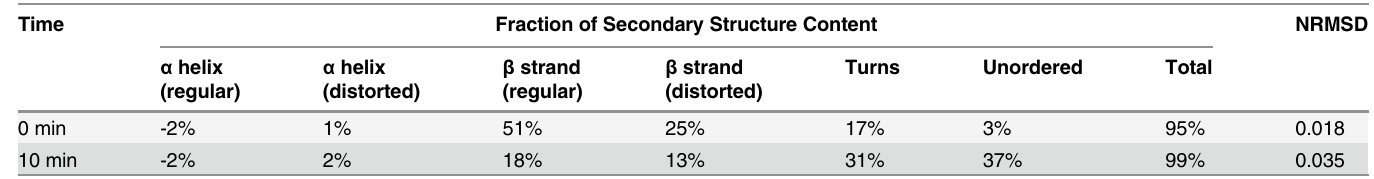
Table 6. Quanti fi cation of the secondary structure of human plasminogen samples (non-illuminated, 0 min; UV illuminated, 10 min at 280 nm) obtained upon far UV CD spectra deconvolution with the algorithm CDSTRR. Time